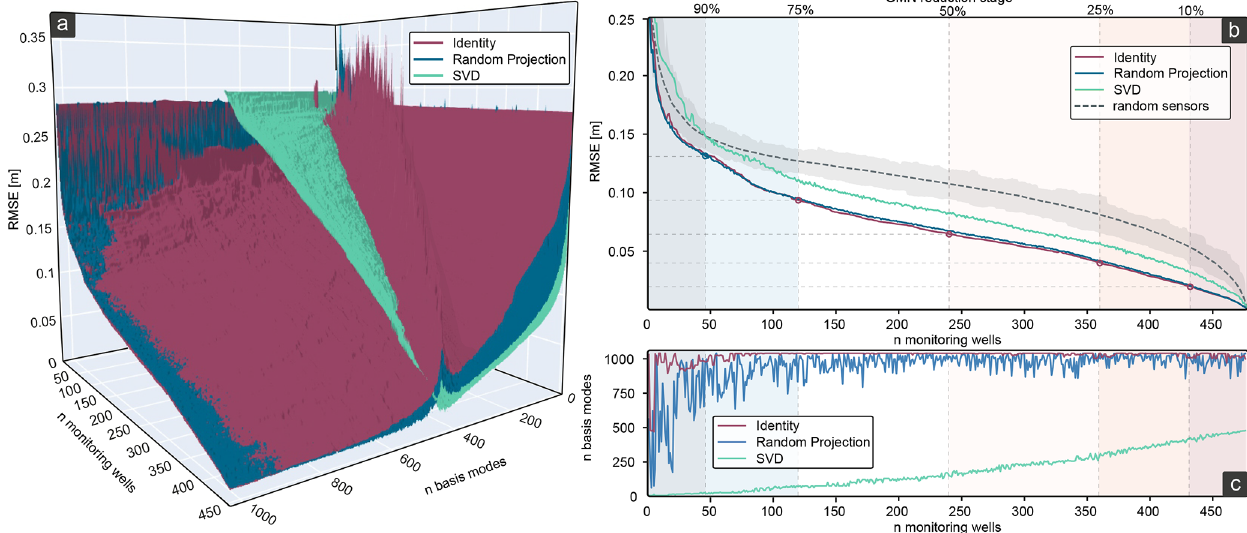
Figure 2. Grid search CV results. (a) Reconstruction error (RMSE) vs. the number of monitoring wells and the number of basis modes for the three basis projections described in Sect. 2.1.3, i.e., identity ( (cid:57) r = X tr ), random projection ( (cid:57) r = GX tr ), and SVD ( (cid:57) r = U tr ). (b) Minimum RMSE achieved with a given number of QR-selected monitoring wells (Pareto front) and the same number of randomly selected wells (median of 100 runs; gray shading represents the total range) for comparison. (c) The corresponding number of basis modes that leads to the lowest RMSE in panel (b) . Accordingly, panels (b) and (c) represent a section through panel (a) at the respective minimum on the axis of n monitoring wells.